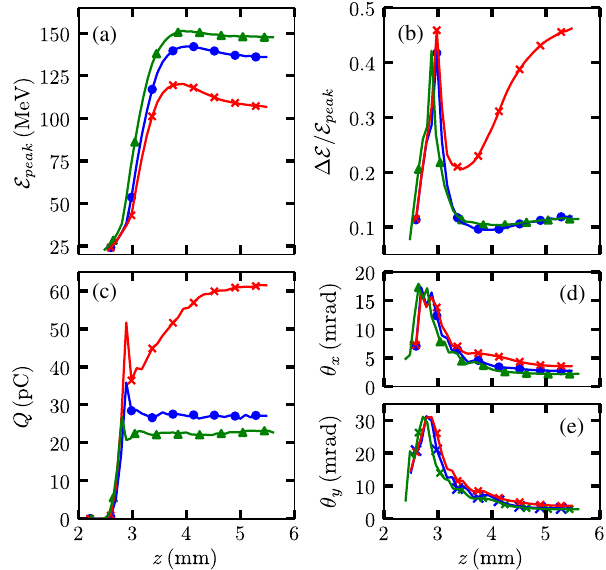
FIG. 11. Evolution of four beam quantities over the longi- tudinal traveling distance: (a) Peak energy ( E energy spread ( Δ E = E ); (c) Charge ( Q ) of electrons; (d) rms values of the angular divergence in x - and (e) in y -directions. In each figure, three curves are represented, each corresponds to a concentration value: 1% (red crosses), 0.5% (blue dots), and 0.35% (green triangles).